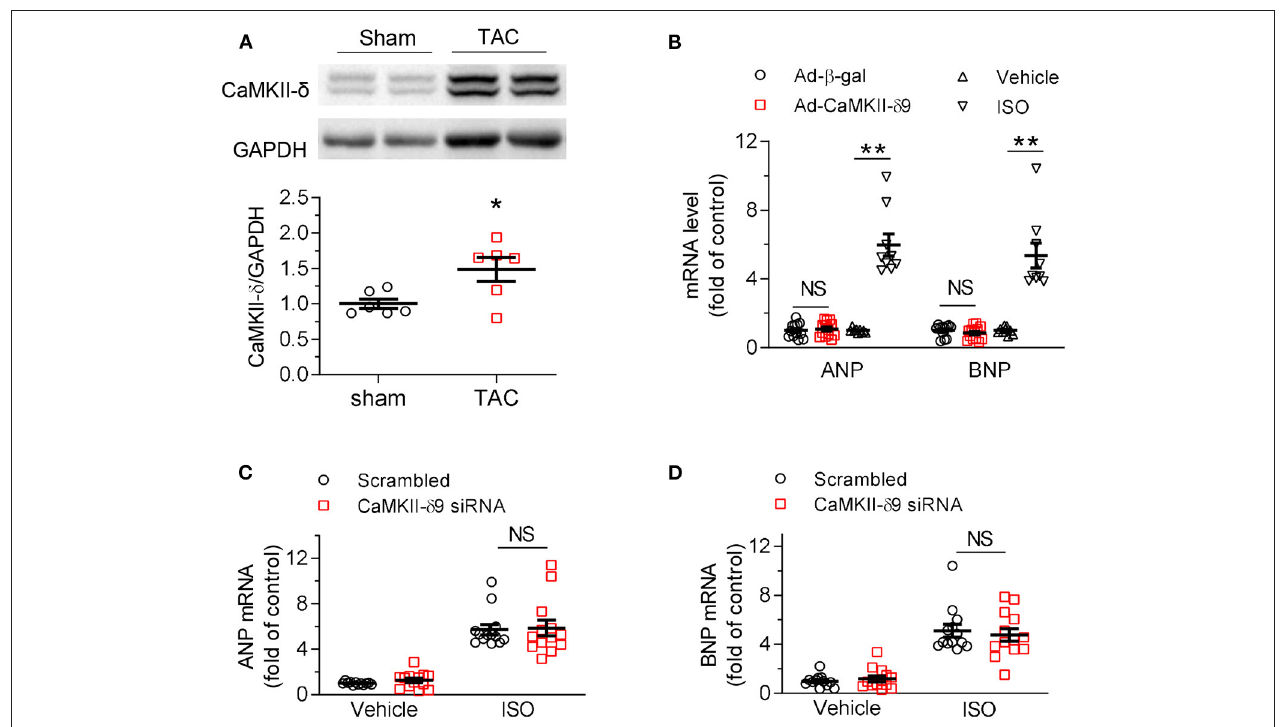
FIGURE 3 | CaMKII- δ 9 does not directly regulate cardiac hypertrophy. (A) Representative western blots and statistical data showing the levels of CaMKII- δ in the hearts of the mice 2 weeks after sham or transverse aortic constriction (TAC) surgery. n = 6. (B) Averaged data of mRNA levels of ANP and BNP assayed by real-time PCR in NRVMs infected with Ad- β -gal or Ad-CaMKII- δ 9 (50 MOI, 48h; Ad- β -gal, n = 12; Ad-CaMKII- δ 9, n = 13). The NRVMs treated with isoproterenol (ISO, 10mM, 24h) were used as positive control ( n = 9). (C,D) Averaged data of mRNA levels of ANP (C) and BNP (D) assayed by real-time PCR in NRVMs transfected with scrambled or CaMKII- δ 9 siRNA with or without ISO treatment (10 µ M, 24h; Vehicle scrambled, n = 12; other groups, n = 13). Data are mean ± S.E.M. * P < 0.05, ** P < 0.01; NS, not significant; Student’s t -test (A,B) , or two-way ANOVA (C,D)